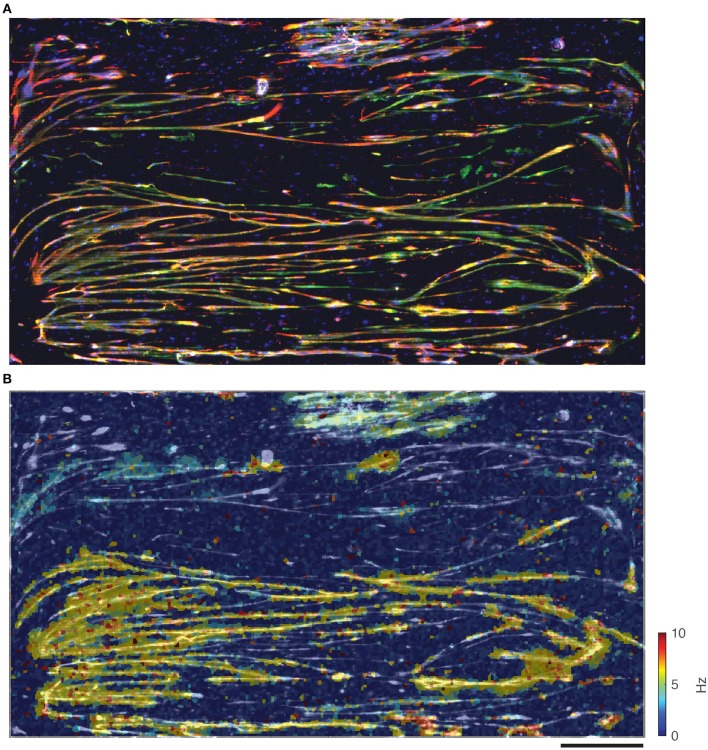
Comparison between immunostained muscle cells and electrical spike activity. (A) Immunostained muscle cells on the electrode area stained for desmin (red), α-actinin (green), and DAPI (blue). (B) Overlay of immunostained cells (in black and white) and activity (spike frequency in color). Scale bar is 0.5 mm.